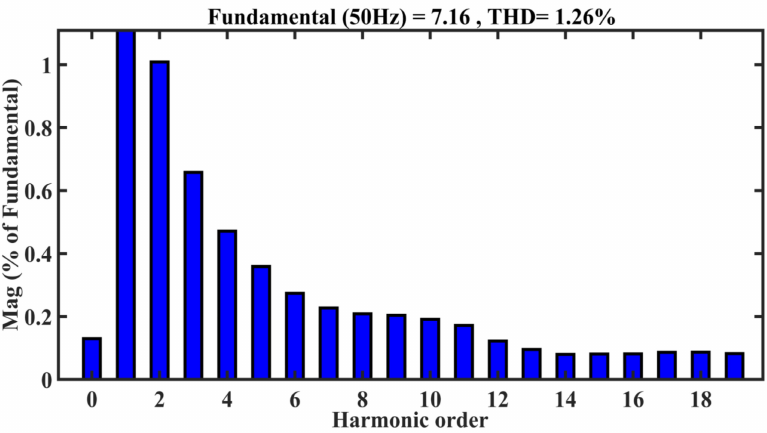
Figure 20. THD analysis of grid current waveform with PSOGA-PI controller.